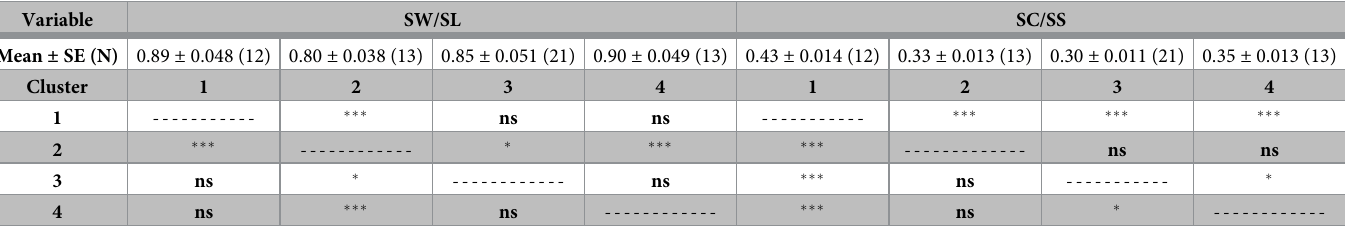
Table 4. Post hoc comparisons of SW/SL and SC/SC ratios among the four shell morphotypes using the unequal N HSD test. Variable SW/SL SC/SS Mean ± SE (N) 0.89 ± 0.048 (12) 0.80 ± 0.038 (13) 0.85 ± 0.051 (21) 0.90 ± 0.049 (13) 0.43 ± 0.014 (12) 0.33 ± 0.013 (13) 0.30 ± 0.011 (21) 0.35 ± 0.013 (13)